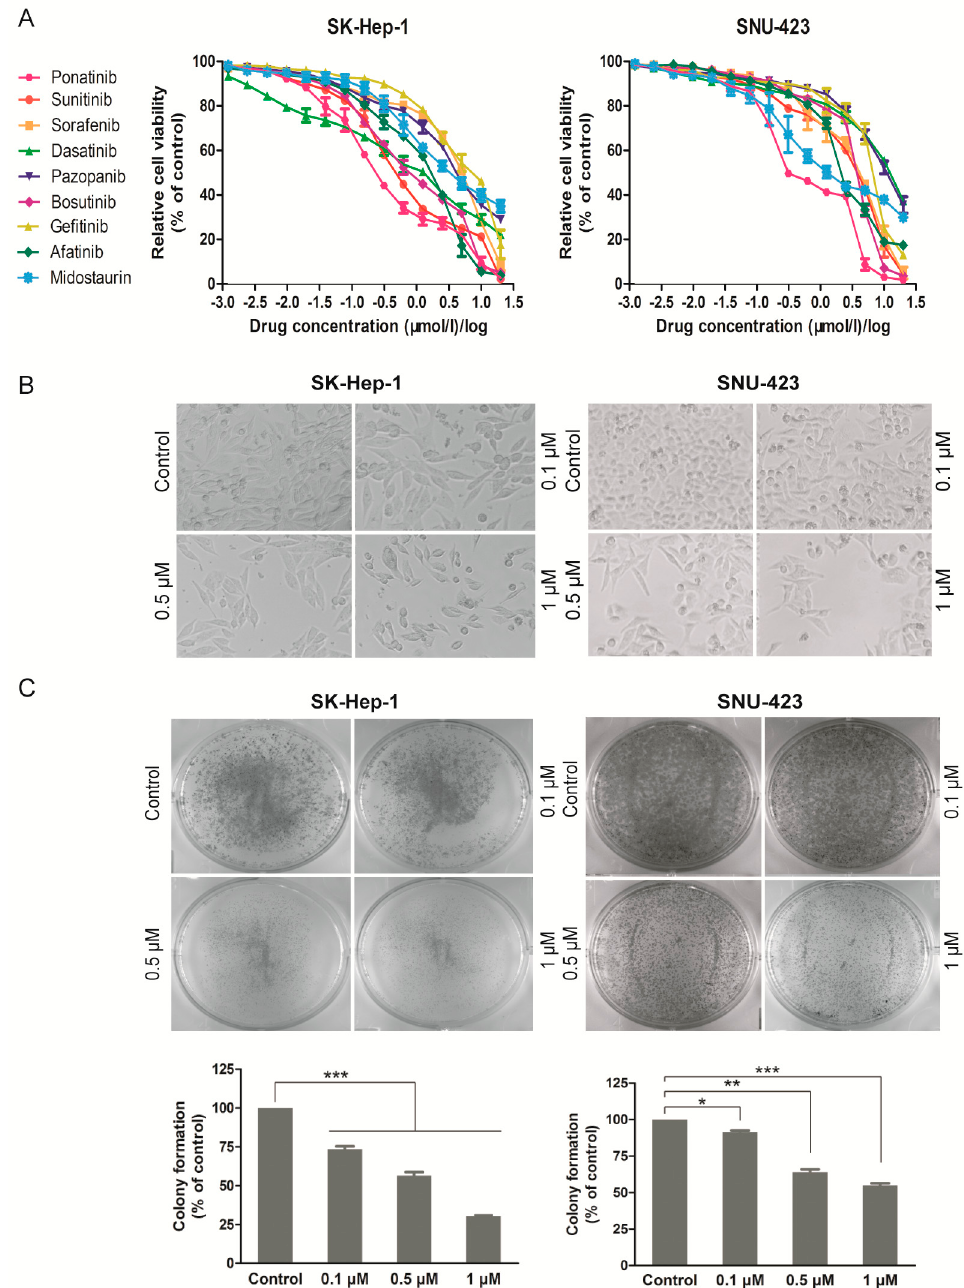
Figure 1. Efficacy of individual PTK inhibitors against different hepatocellular carcinoma (HCC) cell lines and cytotoxicity of ponatinib. ( A ) Cell proliferation was examined by 3-(4,5-dimethyl-2-thiazolyl)-2,5-diphenyl-2-H-tetrazolium bromide (MTT) assay. HCC cell lines including SK-Hep-1 and SNU-423 cells were seeded in 96-well plates and then treated with different concentrations of drugs for 72 h. The relative cell viability was calculated and shown. ( B ) Cell proliferation inhibition was observed by microscopy (×100). SK-Hep-1 and SNU-423 cells were plated in 24-well plates and exposed to indicated doses of ponatinib for 36 h. ( C ) SK-Hep-1 and SNU-423 cells were plated in six-well plates (500 cells/well) and treated with various concentrations of ponatinib for 10 days, then the clonogenic ability was measured and shown. The bars indicate the colony formation ability of different groups. Each experiment was carried out three times. (n = 3; *, p < 0.05; **, p < 0.01; ***, p < 0.001). Table 2. The IC 50 ( μ mol/l) of different single agents in HCC cell lines.